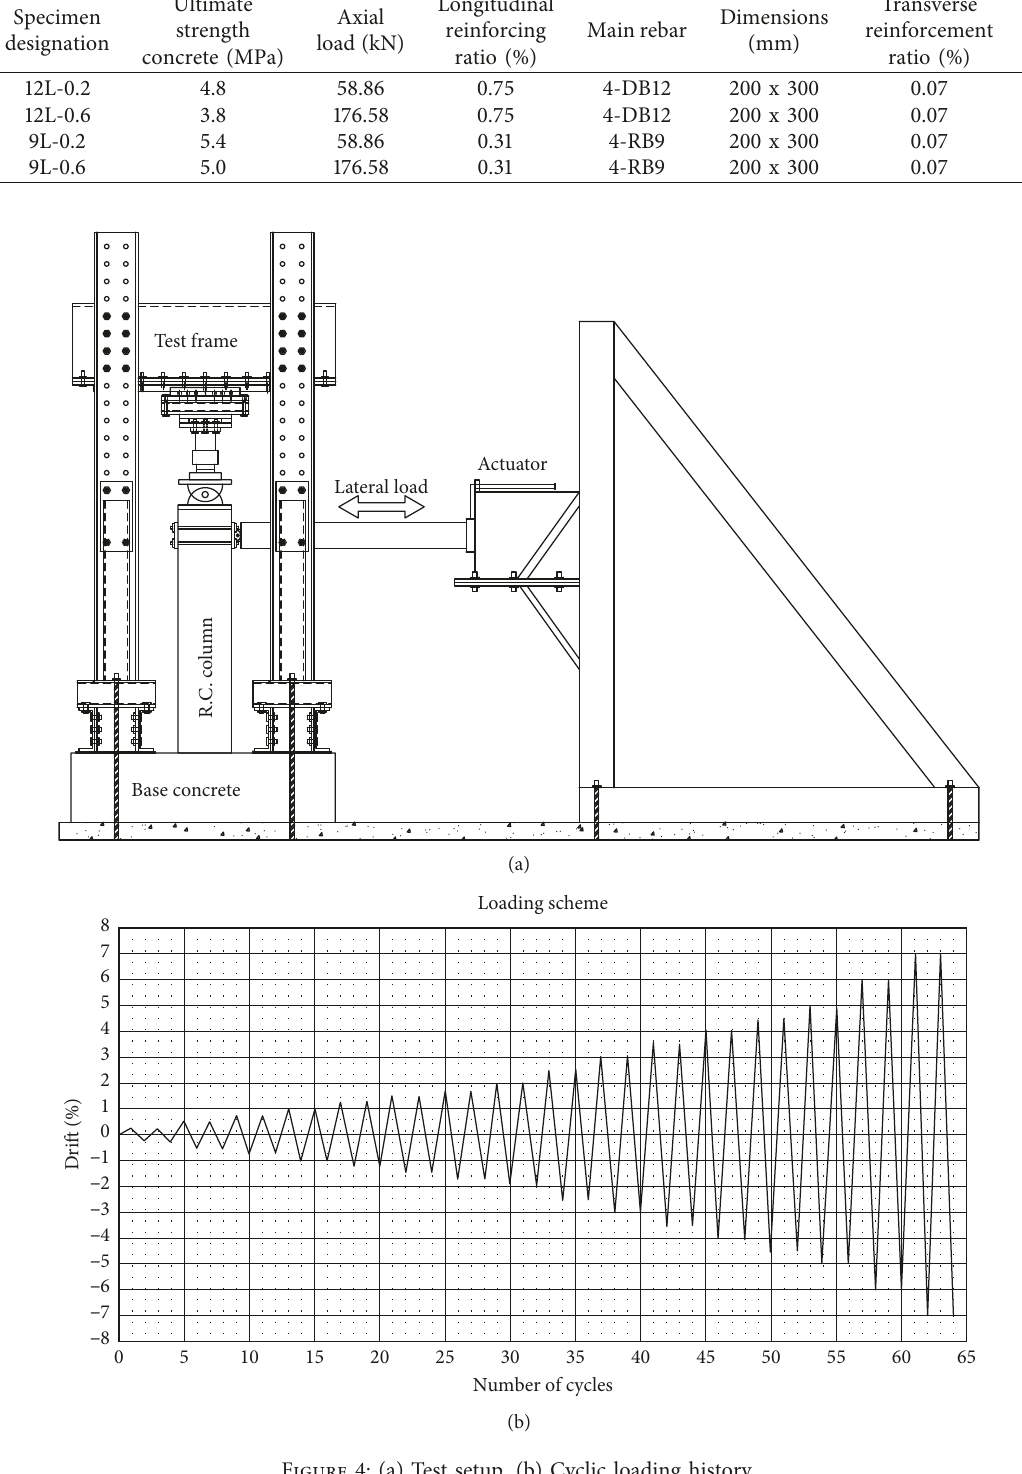
Figure 4: (a) Test setup. (b) Cyclic loading